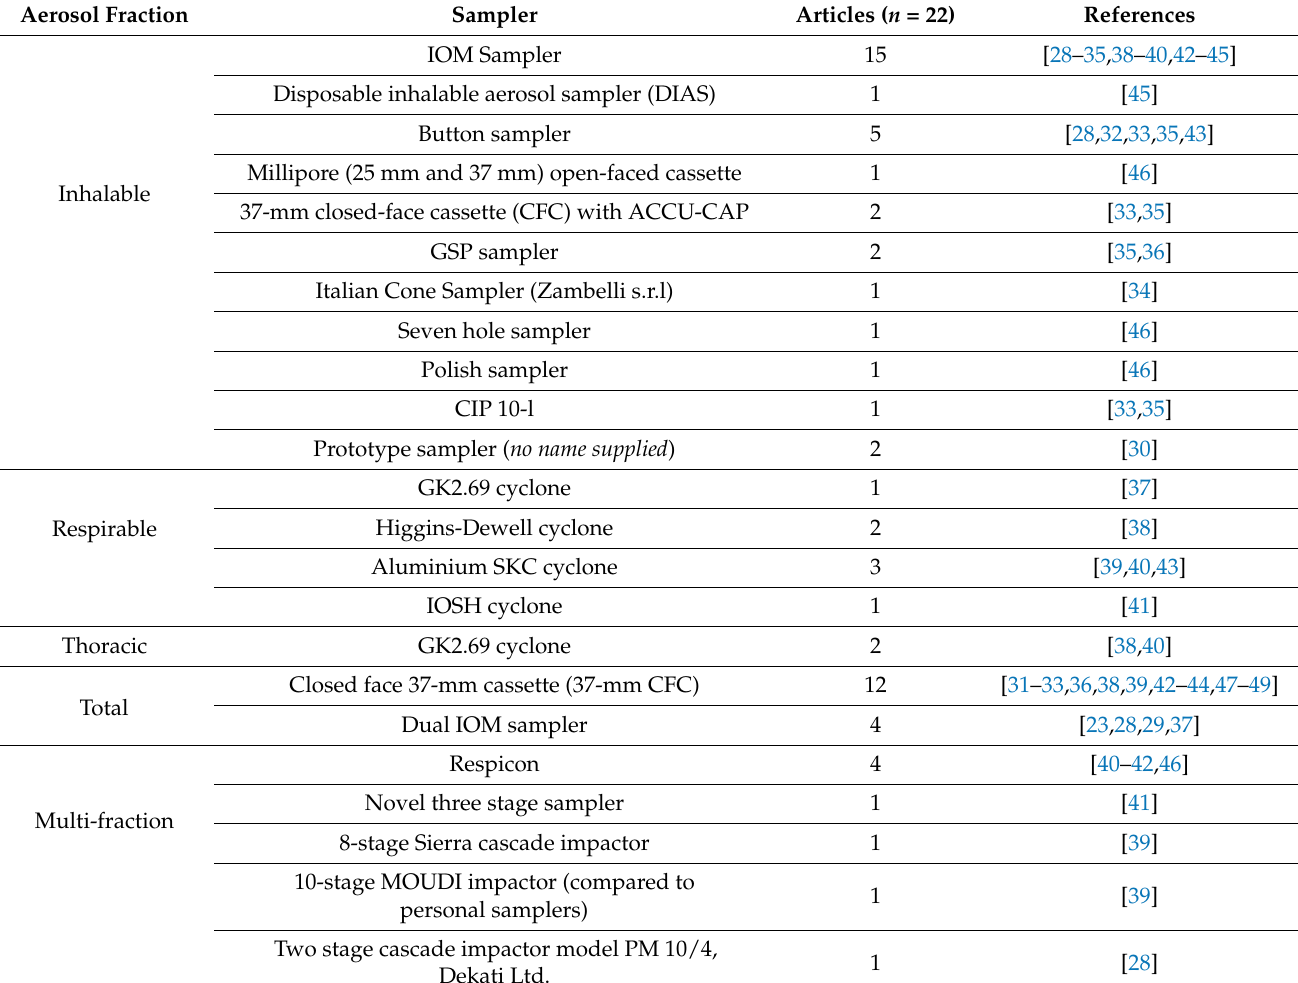
Table 2. Samplers assessed in workplace settings (note—names listed as stated in publication except for the IOM dual sampler). Aerosol Fraction Sampler Articles ( n =